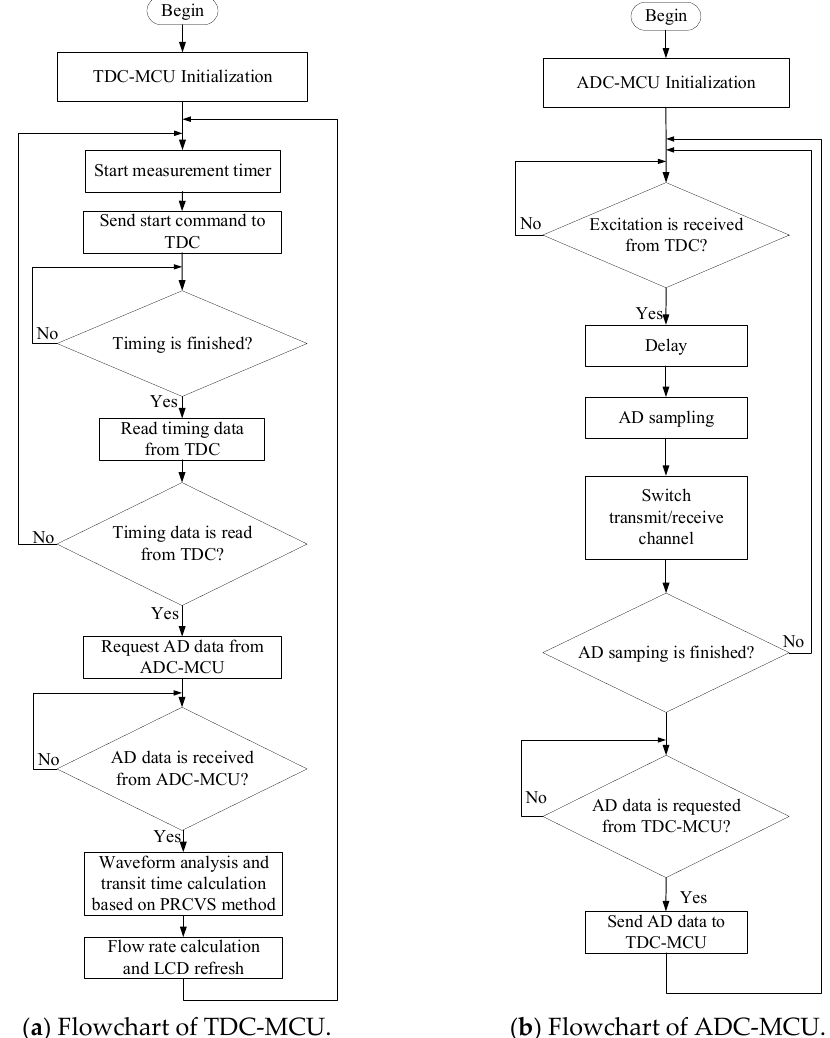
Figure 11. Flowchart of the software of signal processing.